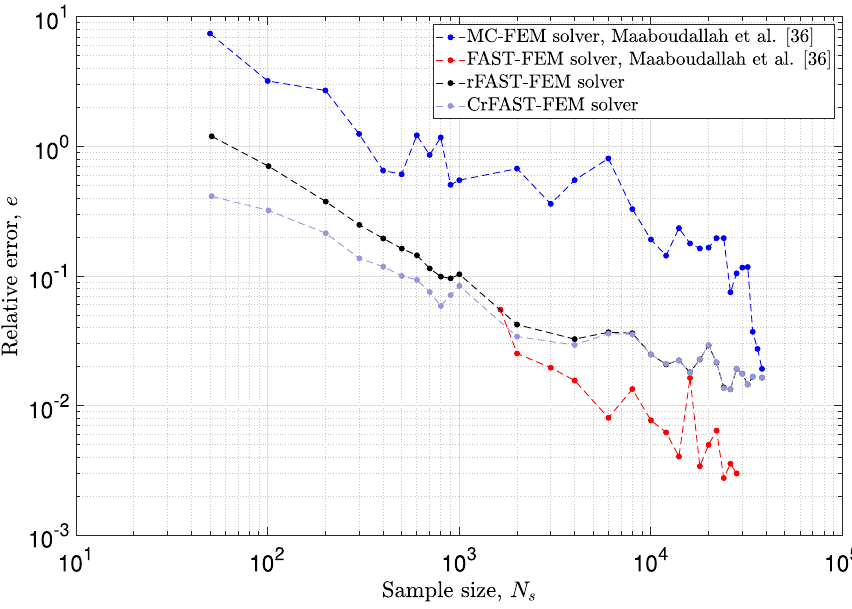
Fig. 5 Relative error for the stochastic finite element approaches. Comparison of the relative error in Eq. (39) between (i) MC-FE, (ii) FAST-FE, (iii) rFAST-FE and (iv) the corrected rFAST-FE